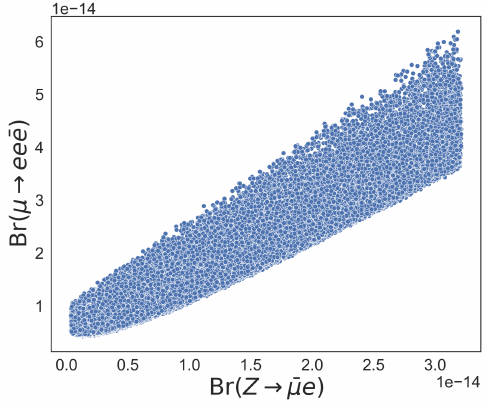
Figure 7 . Scatter plot R (Ti) vs. R